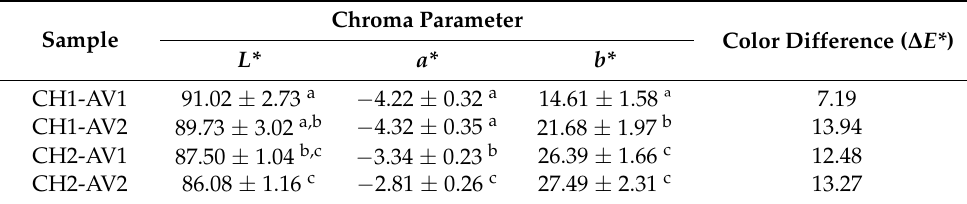
Table 1. Chroma parameters ( L *, a *, b *), and total color difference ( ∆ E *) for aloe vera-loaded chitosan